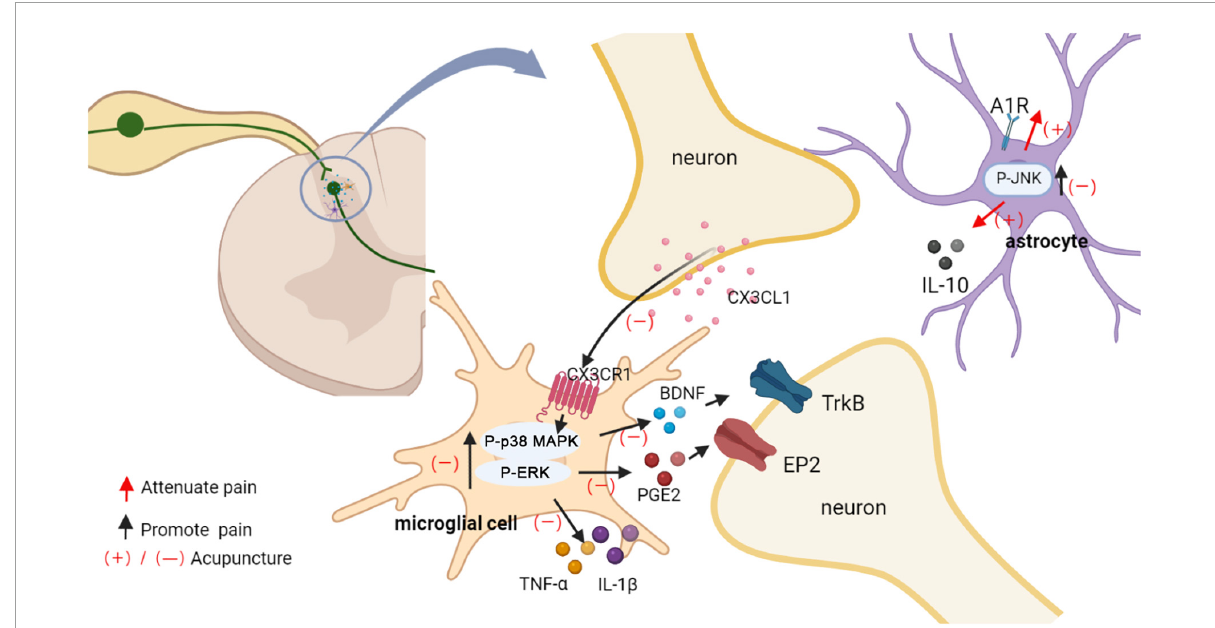
FIGURE6 Acupuncture affects glial activation. EA down-regulated the neuronal chemokine CX3CL1 and prevented the p38 MAPK/ERK signaling pathway, leading to reduced release of TNF- α and IL-1 β , BDNF, PGE2. Released IL-1 β and TNF- α acts on spinal dorsal horn neurons to enhance the neuronal excitability and inflammatory response. PGE2 and BDNF bind to spinal cord neuronal EP2 and Trk B, respectively, inducing a change in their excitatory state and thus causing neuropathic pain. EA induced an increase in adenosine levels in the spinal cord, which in turn activated astrocyte A1Rs to produce an analgesic effect. Additionally, analgesic effect of acupuncture was mediated in part through inhibiting the activation of JNK and promoting the release of IL10 in